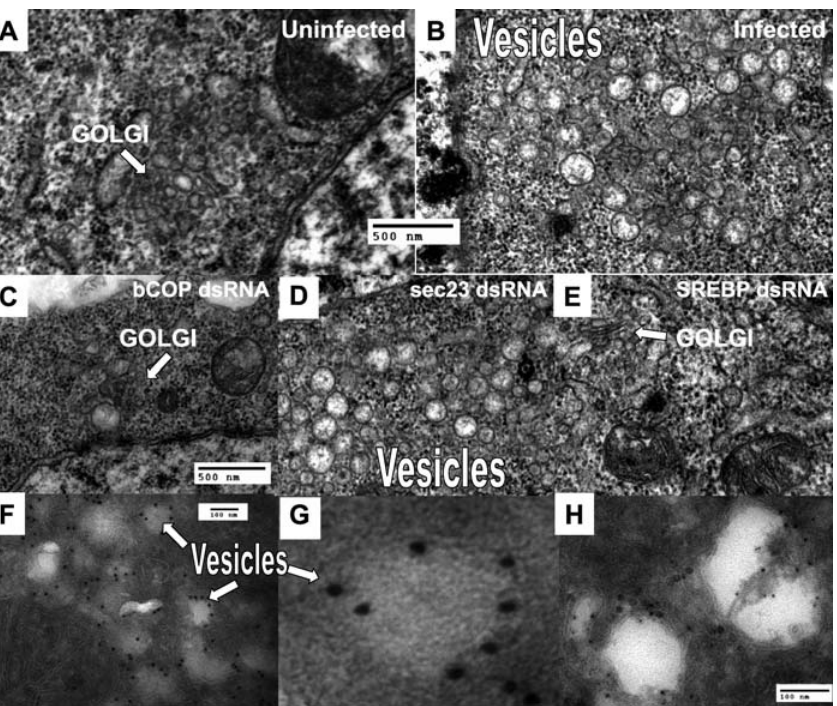
Figure 3. Ultrastructural Analysis Reveals Virus-Dependent Vesicular Compartment (A) Uninfected cells with intact Golgi. (B) Vesicles were generated at 10 h postinfection throughout the cytoplasm of cells pretreated with dsRNA against GFP and infected with DCV. (C–E) Cells were pretreated with dsRNA against COPI (bCOP) (C), COPII (sec23) (D), or SREBP (E), infected with DCV, and prepared for electron microscopy. (F) Immunoelectron microscopy of Drosophila cells infected with DCV and the RNA replication machinery was visualized using anti-DCV helicase and a secondary antibody coupled to 10-nm gold particles. The surfaces of cytoplasmic vesicles (arrows) are stained. (G) Higher-magnification view of DCV helicase–labeled vesicle. (H) Immunoelectron microscopy of Drosophila cells infected with DCV and the RNA replication machinery was visualized using anti-DCV helicase and a secondary antibody coupled to 5-nm gold particles. The Golgi was visualized using an anti-Golgi antibody (DG13) and a secondary antibody coupled to 12-nm gold particles. DOI: